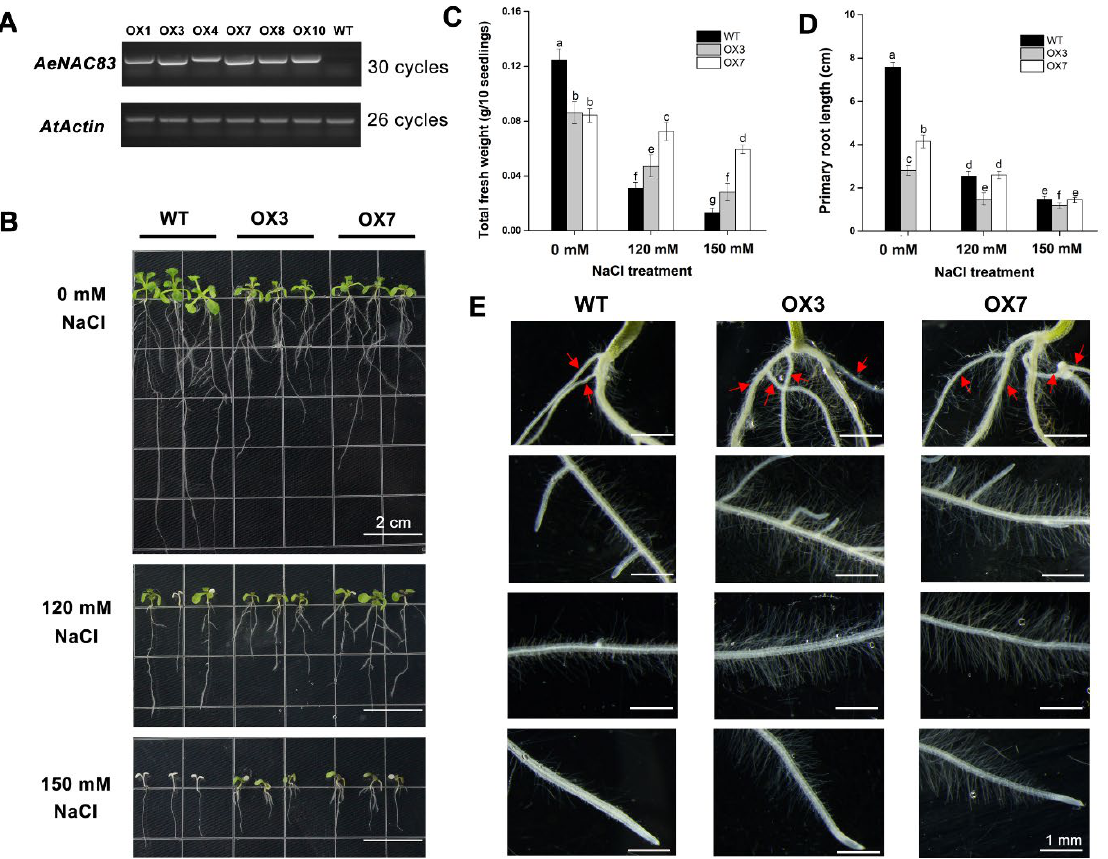
Figure 4. Roles of AeNAC83 in salt tolerance and in growth in Arabidopsis transgenic plants. Four- day-old seedlings of wild-type (WT) and two transgenic lines (OX3 and OX7) were transplanted on 1/2 MS medium supplemented with 0, 120, or 150 mM NaCl for 10 days. ( A ) Semi-quantitative analysis of AeNAC83 gene expression in wild-type (WT) and AeNAC83 -overexpression transgenic plants. The first bands show AeNAC83 gene expression (30 cycles) and the bands below show AtActin gene expression (26 cycles) used as internal control. ( B ) Phenotypes of seedlings on 1/2 MS medium supplemented with 0, 120, or 150 mM NaCl, respectively. ( C , D ) Fresh weight and primary root length of seedlings at the end of the experiment in ( B ). Data are presented as mean ± SD ( n = 10). Different letters denote significant differences at p < 0.05, using ANOVA and Duncan’s multiple tests. ( E ) Root phenotype of seedlings on 1/2 MS medium without NaCl treatment. The red arrows indicated the crown root.